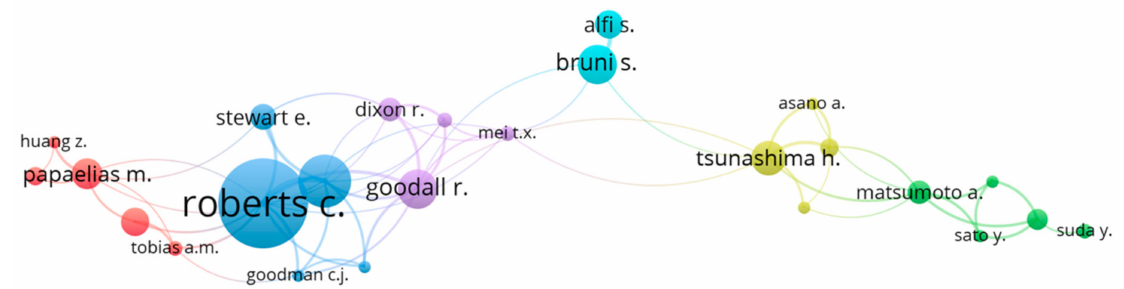
Figure 11. Cooperation in publication and citation of the researchers cited in the case of the internal keywords “condition monitoring”. Source: Own study applied with the use of the VOSviewer software (version